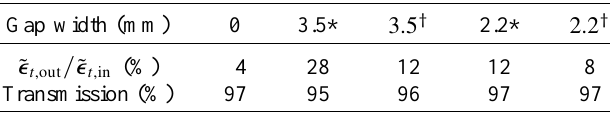
TABLE II. Main results about gaps effects ( (cid:1) : gaps at exactly 2, 4, and 6 m; y : gaps at Young’s location). Gap width